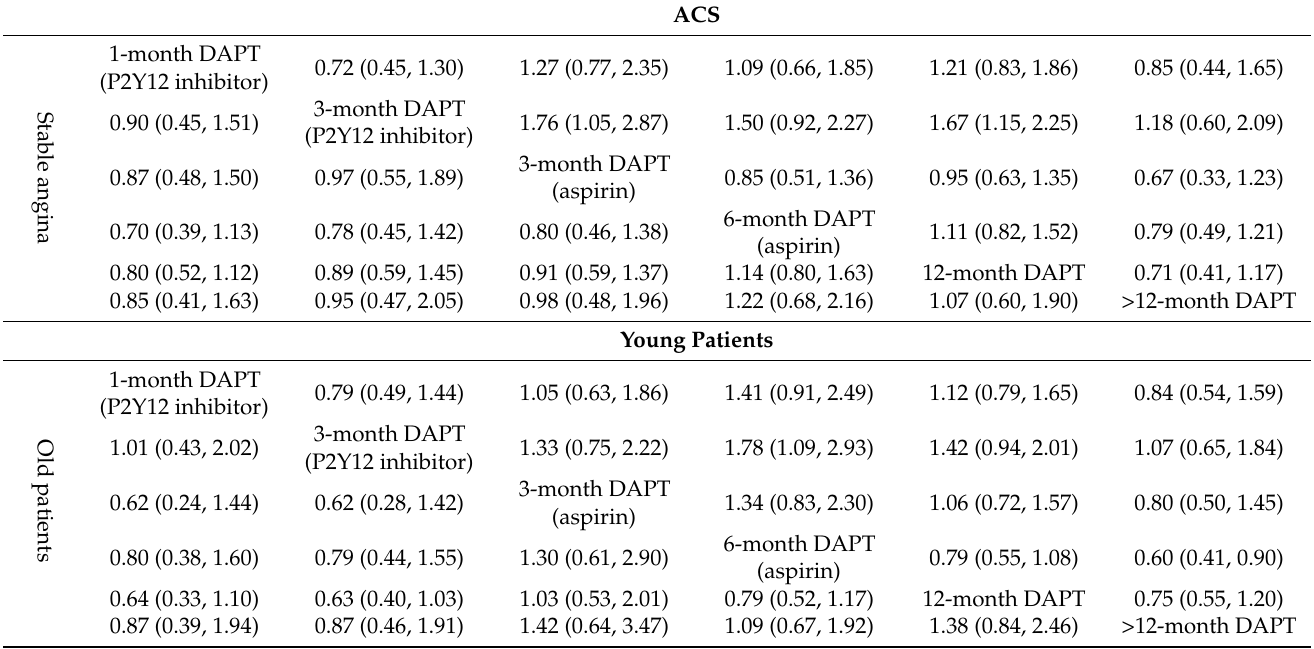
Table 3. Subgroup Analyses of Primary Outcomes with Six DAPT Strategies.